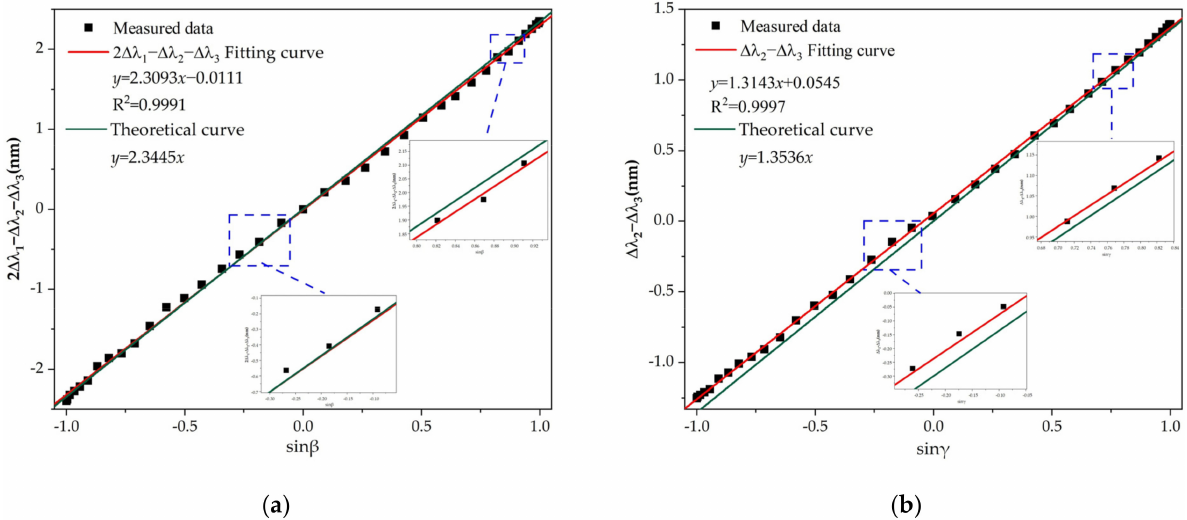
Figure 7. The measured relationship of the central wavelength shift vs. the sine of the attitude angle. ( a ) Central wavelength shift vs. the sine of the pitch angle. ( b ) Central wavelength shift vs. the sine of the roll